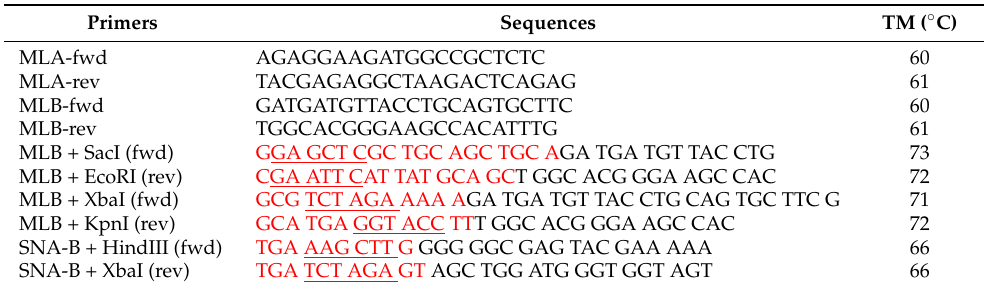
Table 1. Primers used in polymerase chain reaction, introduced restriction sites and added nucleotides shown in red; actual site underscored; main lectin sequence shown in black.